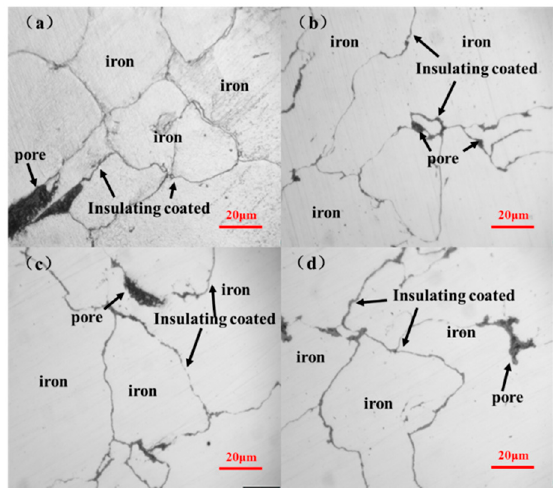
Figure 5. Metallographs of the hybrid-coated compacts by the ball-milling method with various additional amounts of Al 2 O 3 ( a ) 2%; ( b ) 4%; ( c ) 6%; ( d ) 8%.